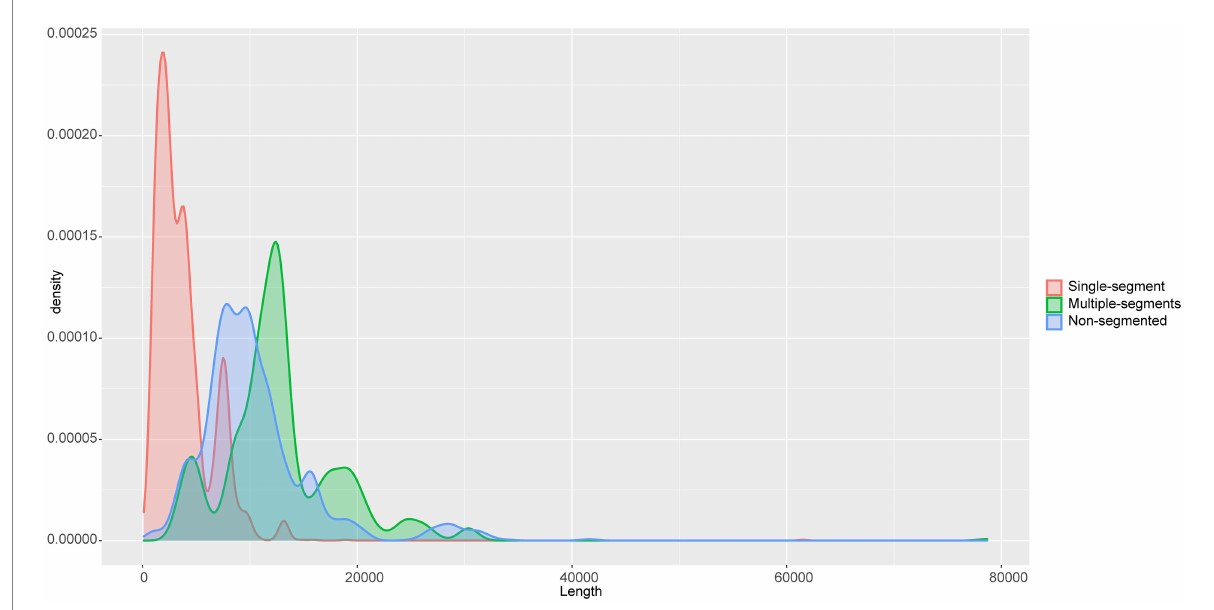
FIGURE. 3 Density plot of genome lengths between single-segment, multiple-segments, and non-segmented viruses. The horizontal axis is the length of the viral